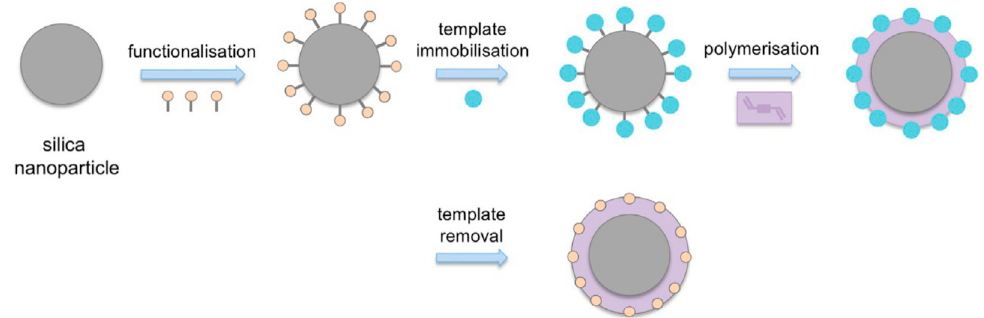
Figure 4. General preparation scheme for surface imprinting on a nanoparticle (adopted from Riedel and Mizaikoff 2019 [79] with permission).